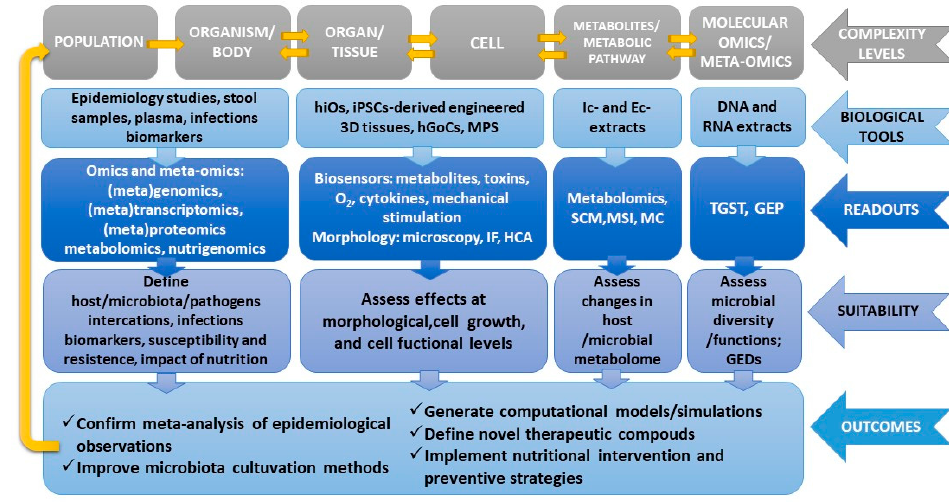
Figure 3. Overview of the novel available tools and readouts applicable to study the links between nutrition, infectious diseases, and microbiota in a human-relevant setting that accounts for multiple levels of complexity, from the molecular to the population level. MPS, microphysiological systems; iPSCs, induced pluripotent stem cells; IF, immunofluorescence; HCA, high-content analysis; MS, mass spectrometry; GEP, gene expression profiling; Ic and Ec, intracellular and extracellular; GEDs, gene expression dysregulations; MC, mass cytometry; MSI, high-resolution mass spectrometry imaging; SCM, Single-Cell Metabolomics; TGST, third-generation sequencing technologies; hiOs, human intestinal organoids; hGoCs, human